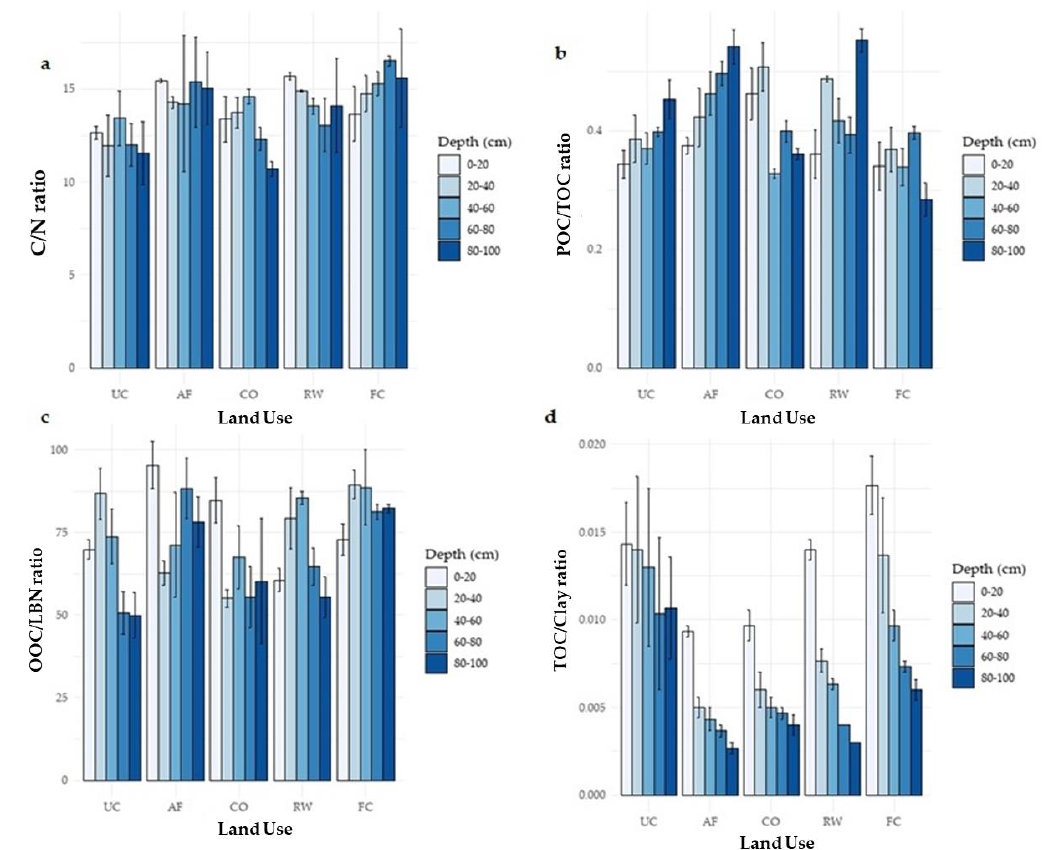
Figure 5. Indicators of soil organic carbon and nitrogen ( a ) C/N ratio, ( b ) POC/TOC ratio, ( c ) OOC/LBN ratio and ( d ) TOC/Clay ratio at various soil depths in various land use systems. UC, uncultivated; AF, agroforestry; CO, citrus orchard; RW, rice – wheat system; FC, forage crop.